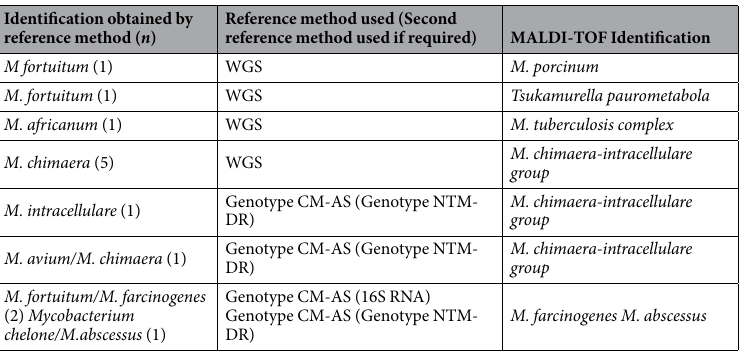
Table 4. Results which were discrepant between those obtained by MALDI-TOF and the reference